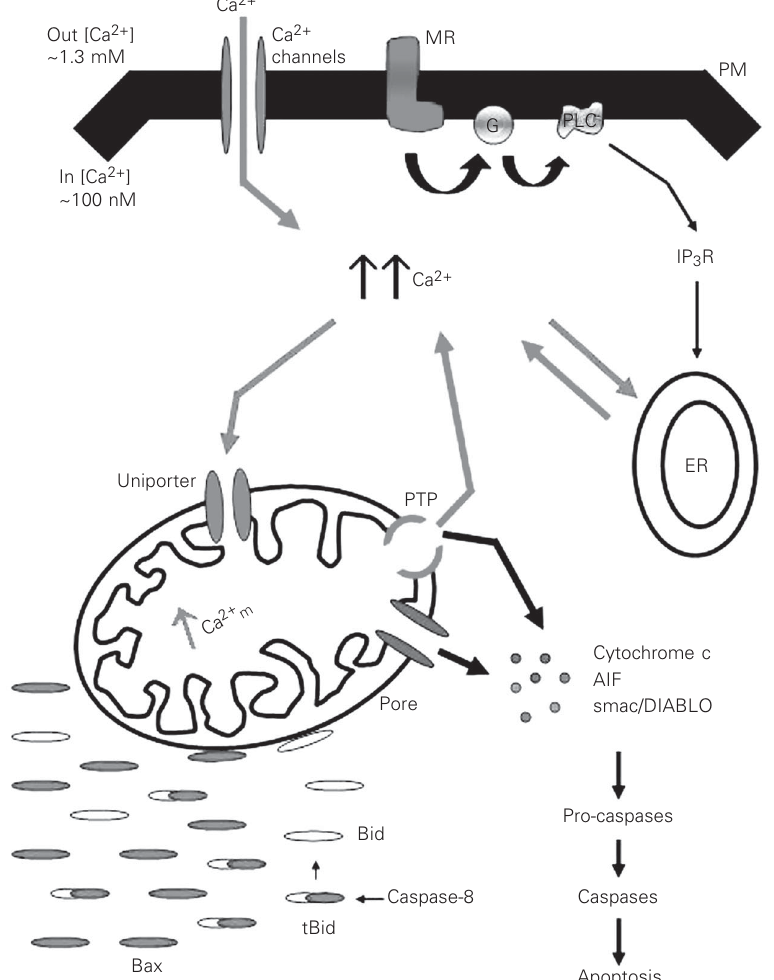
Figure 1. Ca 2+ homeostasis and signaling under physiological and cell death conditions. Without stimuli, extracellular Ca 2+ concentration is approximately 1.3 mM and cytosolic concentration is about 100 nM. When metabotropic receptors (MR) are stimulated cytoso- lic Ca 2+ increases either by opening of membrane Ca 2+ channels or release from intracellu- lar stores. Transient increases in cytosolic Ca 2+ stimulate mitochondrial uptake of Ca 2+ which is found in close proximity to the sarcoendoplasmic reticulum. Mitochondrial Ca 2+ (Ca 2+ m) accumulation leads to opening of the permeability transition pore (PTP; either at a high or low conductance). In the presence of an apoptotic signal cells may overexpress pro- apoptotic proteins such as Bax and Bid. Bax can translocate from the cytosol to the membranes, especially mitochondria. When Bid is cleaved (truncated Bid, tBid) by cas- pases, Bid translocates into the mitochondria increasing Bax toxicity. Bax and Bid lead to a permeabilization of mitochondrial membranes via mechanisms that are still under investiga- tion (e.g., pore formation, opening of PTP). This permeabilization leads to the release of cytochrome c and other factors such as apoptosis-inducing factor (AIF), second mitochon- drial activator of caspases (smac/DIABLO) that activate pro-caspases and down caspases that execute the proteolytic cascade, DNA fragmentation and cell death. During apoptotic stimuli, Ca 2+ may be released from the endoplasmic reticulum (ER) and be taken up by mitochondria. The Ca 2+ content of the intracellular stores can accelerate apoptosis, but the exact relationship between Ca 2+ signaling and apoptosis is still unknown. PM, plasma membrane; IP 3 R, inositoltriphosphate receptor; G, G protein; PLC,